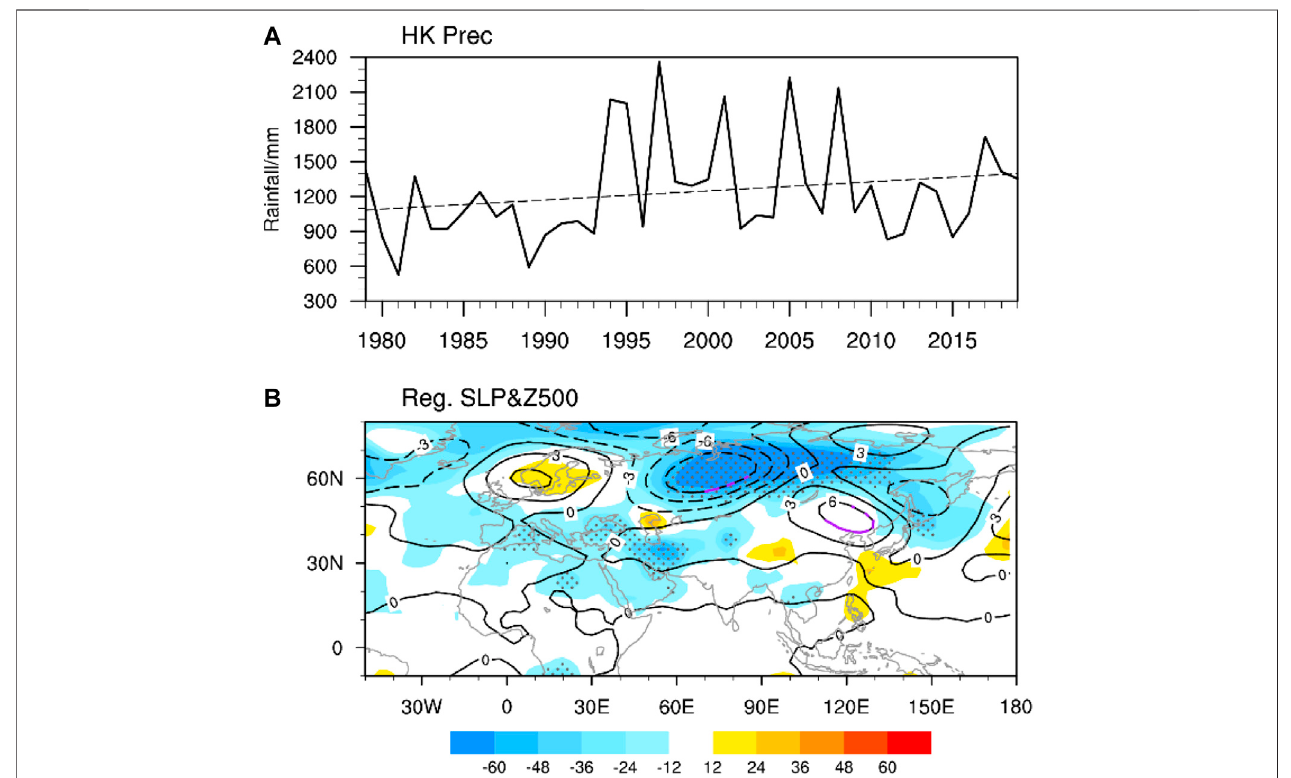
FIGURE 1 | (A) Time series of summer (June-July-August, JJA) rainfall at the HKO Headquarters (HK Prec, mm) for the period 1979 – 2019. (B) Regression of summer mean sea level pressure (shading, Pa) and 500-hPa geopotential height (contour intervals: 3 m) onto summer HK Prec. Stippling and purple contours are signi fi cant at the 95% con fi dence